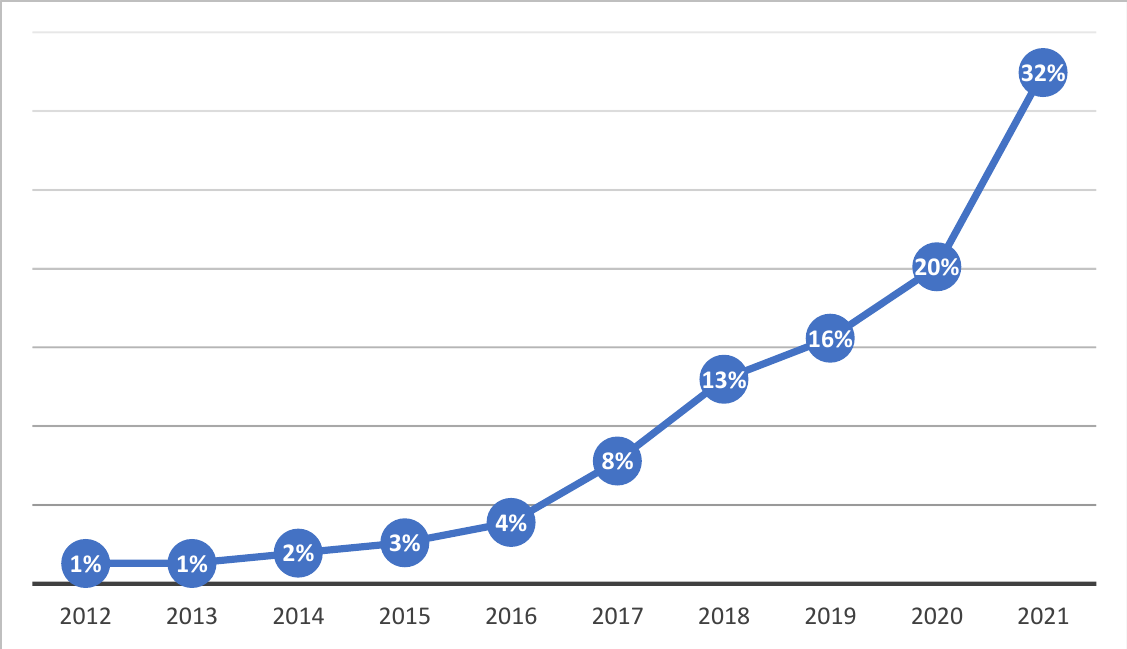
Figure 4. Distribution of publications by year (2012 – 2021).